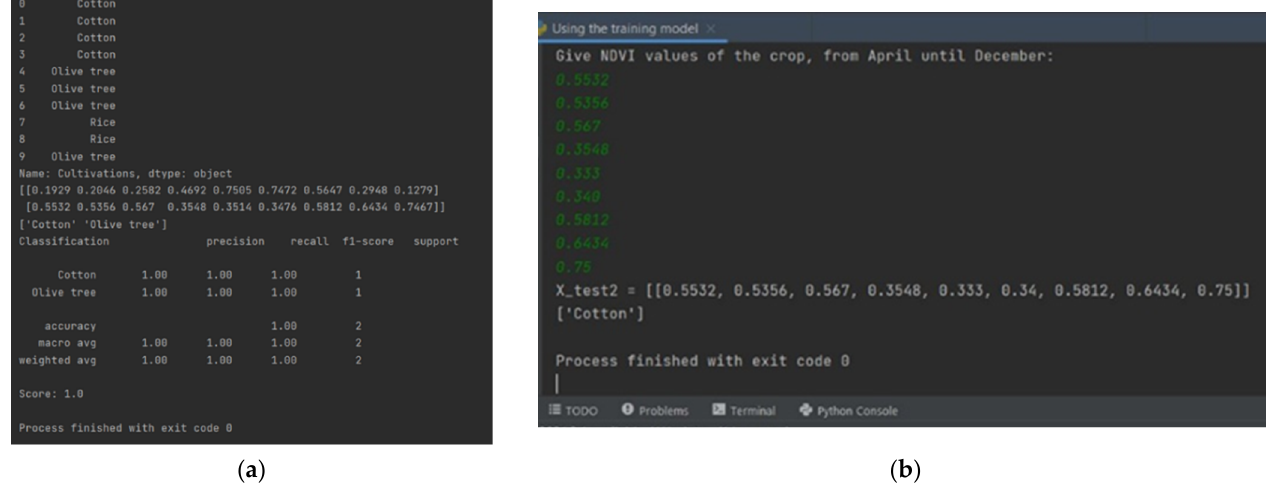
Figure 3. ( a ) Testing results by trained machine learning algorithm; ( b ) Input for the unknown crop’s NDVI values and identification prediction.